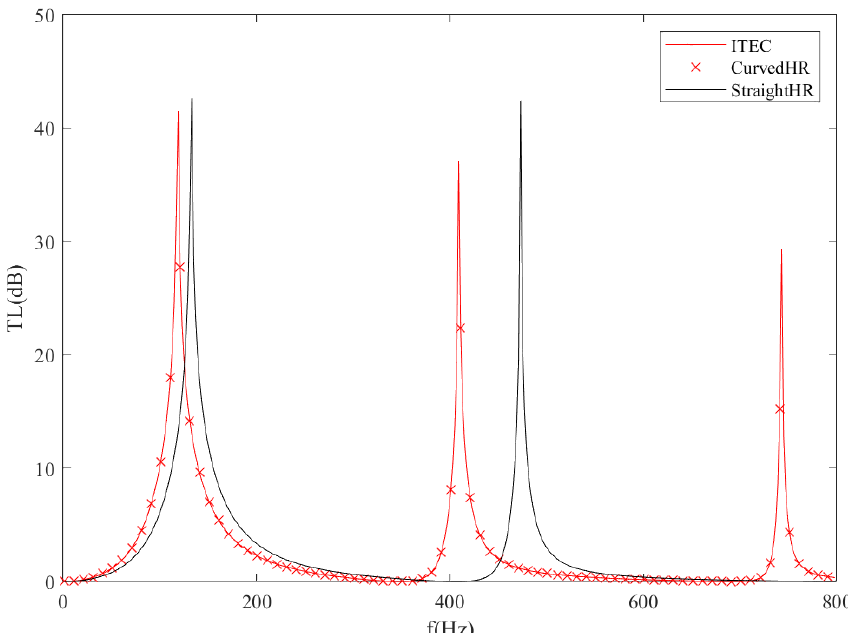
Table 3. Parameters of L N and L EC of ITECs in Figure 7. Figure 6. Comparison of the simulated transmission loss results between the ITEC and the curved HRs and parallel HRs systems; the red lines represent the ITEC results, black lines represent parallel HRs system results, and the red dotted crosses represent curved HRs system results.